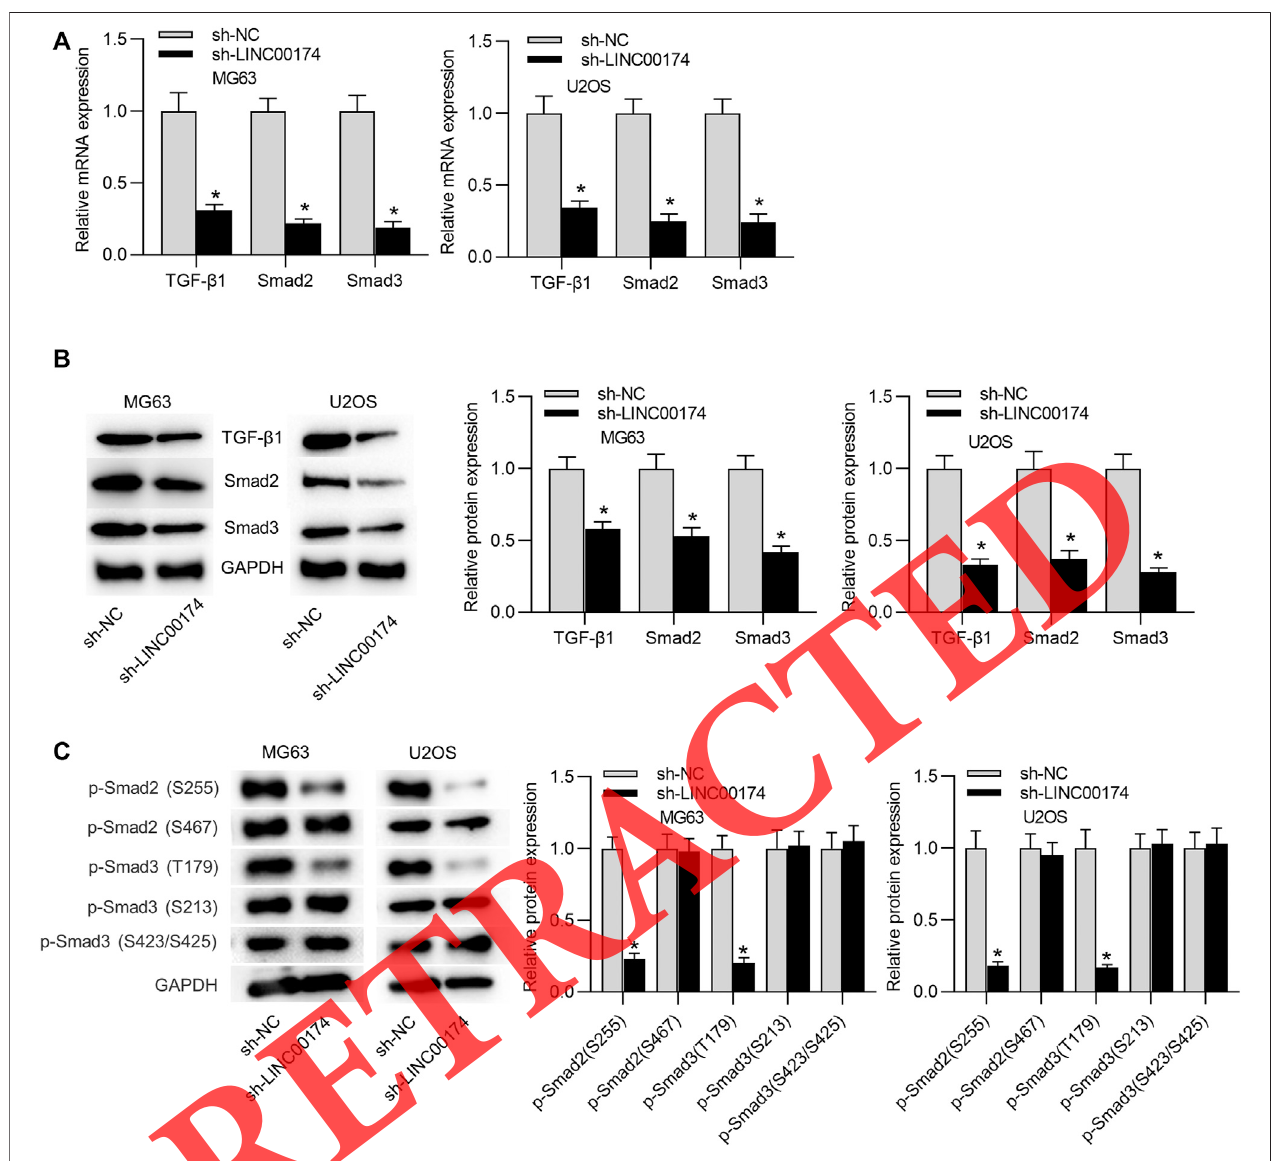
FIGURE 3 | LINC00174 knockdown inhibits the TGF- β /SMAD pathway. (A) The mRNA expression levels of TGF- β 1, SMAD2, and SMAD3 in OS cells in sh- LINC00174 or sh-NC group was determined by RT-qPCR analysis. Signi fi cance was analyzed by Student ’ s t-test. (B) Western blot was performed to measure the protein levels of TGF- β 1, SMAD2, and SMAD3 in OS cells in sh-LINC00174 or sh-NC group. Signi fi cance was analyzed by Student ’ s t-test. (C) Expression of Smad2 (phospho S255), Smad2 (phospho S467), Smad3 (phospho T179), Smad3 (phospho S213), Smad3 (phospho S423/S425) in MG63 and U2OS cells in the presence and absence of LINC00174 was detected by western blotting. Signi fi cance was analyzed by Student ’ s t-test. * p < 0.05.